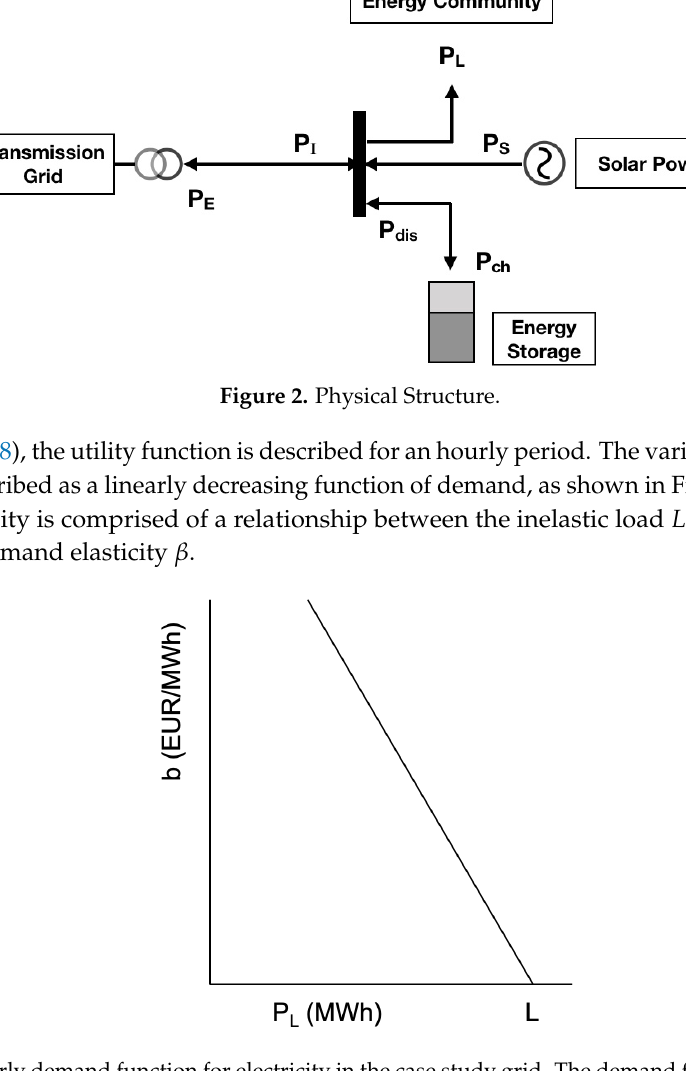
Figure 3. Hourly demand function for electricity in the case study grid. The demand function intersects the y-axis at the original value of the demand L [ t ]